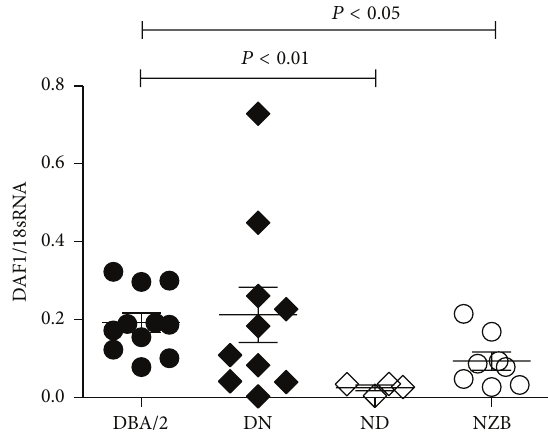
Figure 6: Hmr1 locus does not control Daf1 expression. NZB and DBA/2 mice were made congenic for the Hmr1 locus and Daf1 expression determined from spleen cells. NZB.DBA/ 2 - 𝐻𝑚𝑟1(𝐷𝑎𝑓1 DBA /2 ) = ND ; DBA /2. NZB- 𝐻𝑚𝑟1 (𝐷𝑎𝑓1 NZB ) = DN ; 𝑁 = 4 – 11